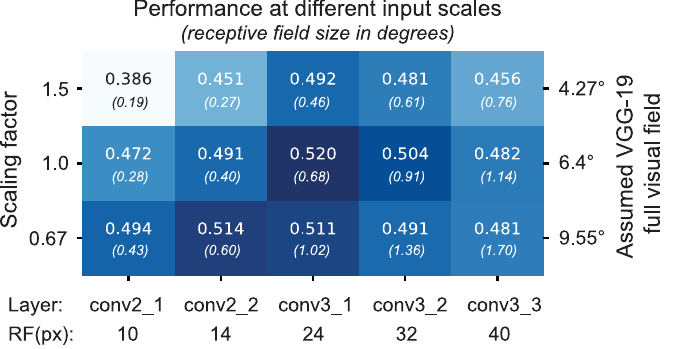
Fig 5. VGG-19 based model performance at different input scales. The performance on test set of cross-validated models that use as feature spaces layers conv2_1 to conv3_3 for different input resolutions. With the original scale used in Fig 4, we assumed that VGG-19 was trained with 6.4 degrees field of view. Scaling this resolution by a factor of 0.67 and 1.5 justifies the original choice of resolution for further analysis. At the bottom, the receptive field sizes in pixels of the different layers are